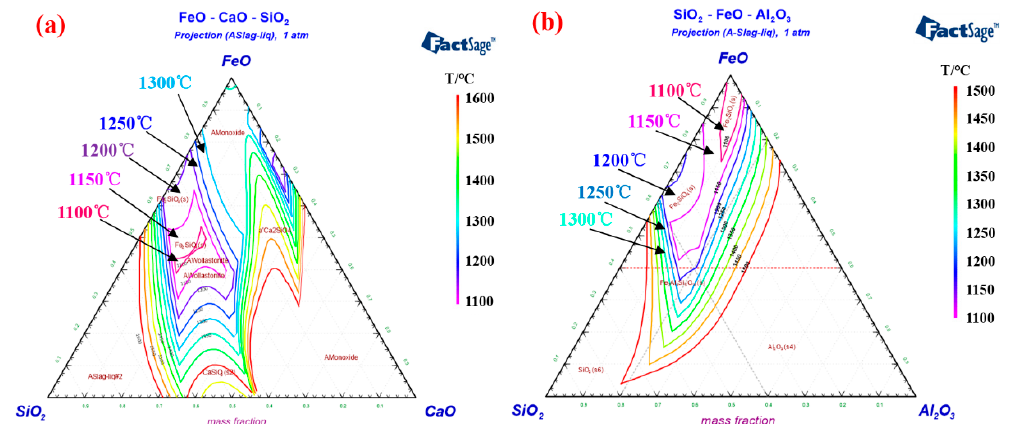
Figure 9. The phase diagram, including ( a ) phase diagram of FeO-CaO-SiO 2 ; ( b ) phase diagram of FeO-Al 2 O 3 -SiO 2 .